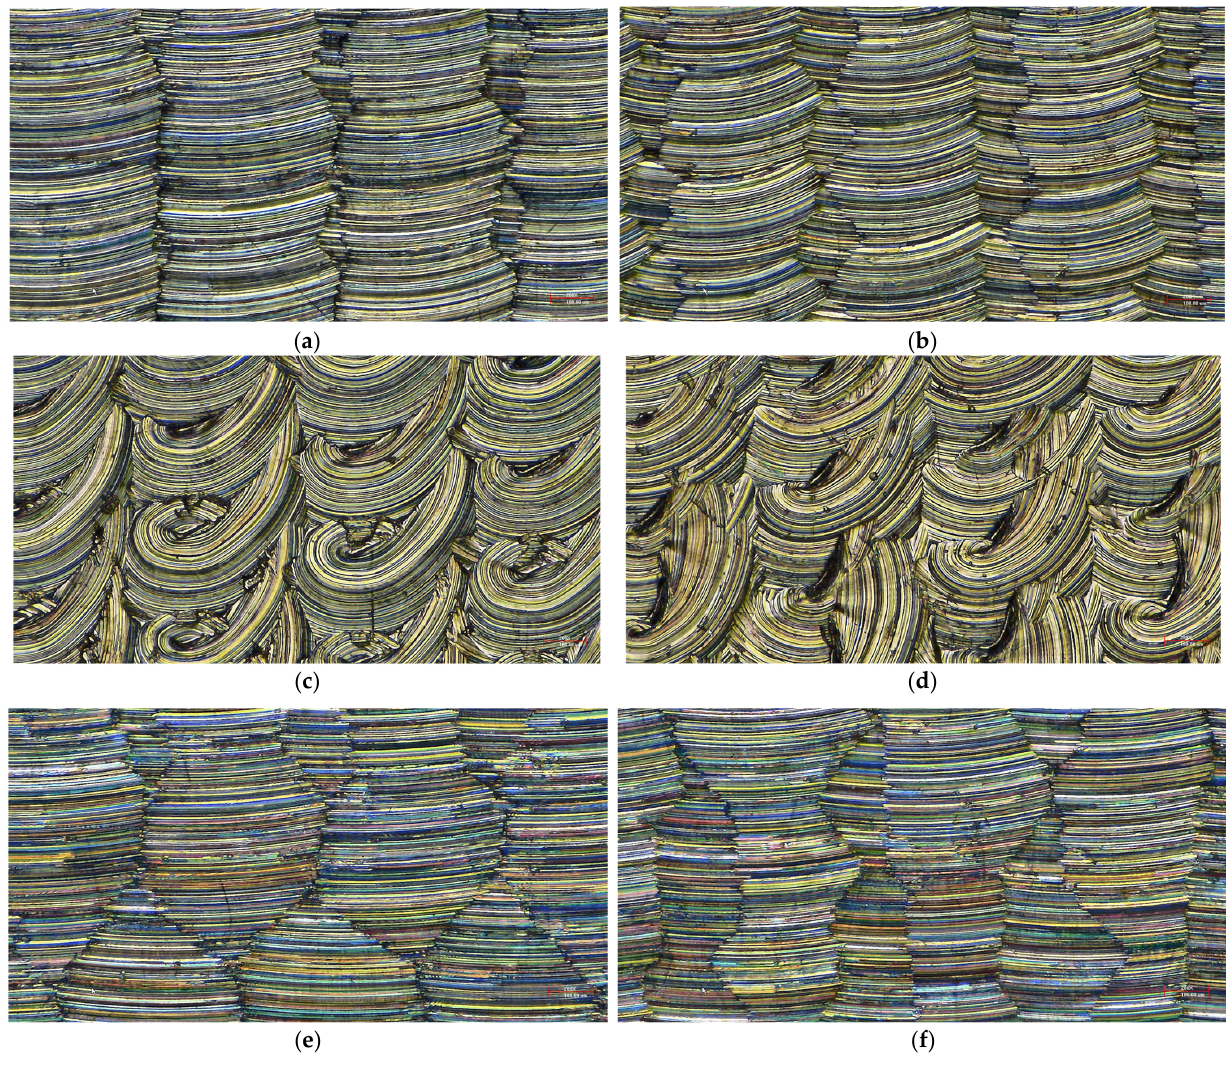
Figure 24. Comparison of workpiece surface between DACT and BEM: ( a ) surface machined by DACT with inclination angle of approximately 10°; ( b ) surface machined by BEM with inclination angle of approximately 10°; ( c ) surface machined by DACT with inclination angle of 0°; ( d ) surface machined by BEM with inclination angle of 0°; ( e ) surface machined by DACT with inclination angle of approximately 20°; ( f ) surface machined by BEM with inclination angle of approximately 20°.